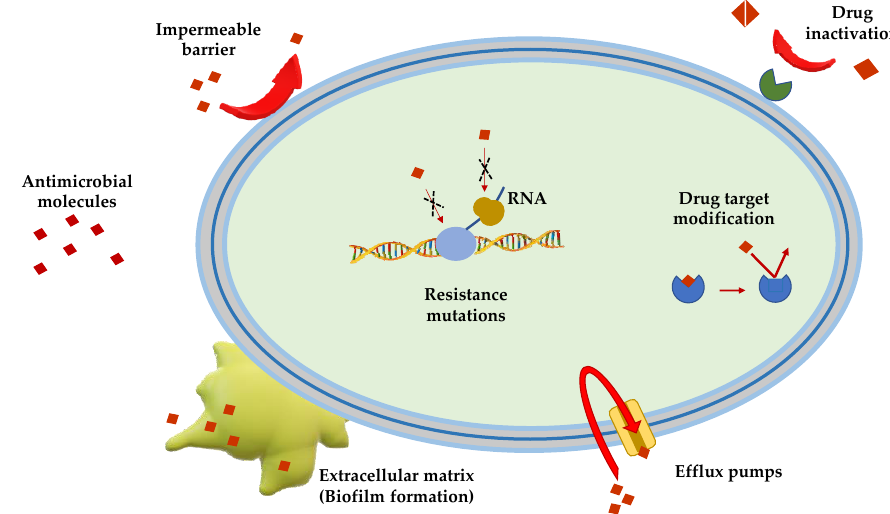
Figure 1. Schematic representation of the principal mechanisms of antibiotic resistance .